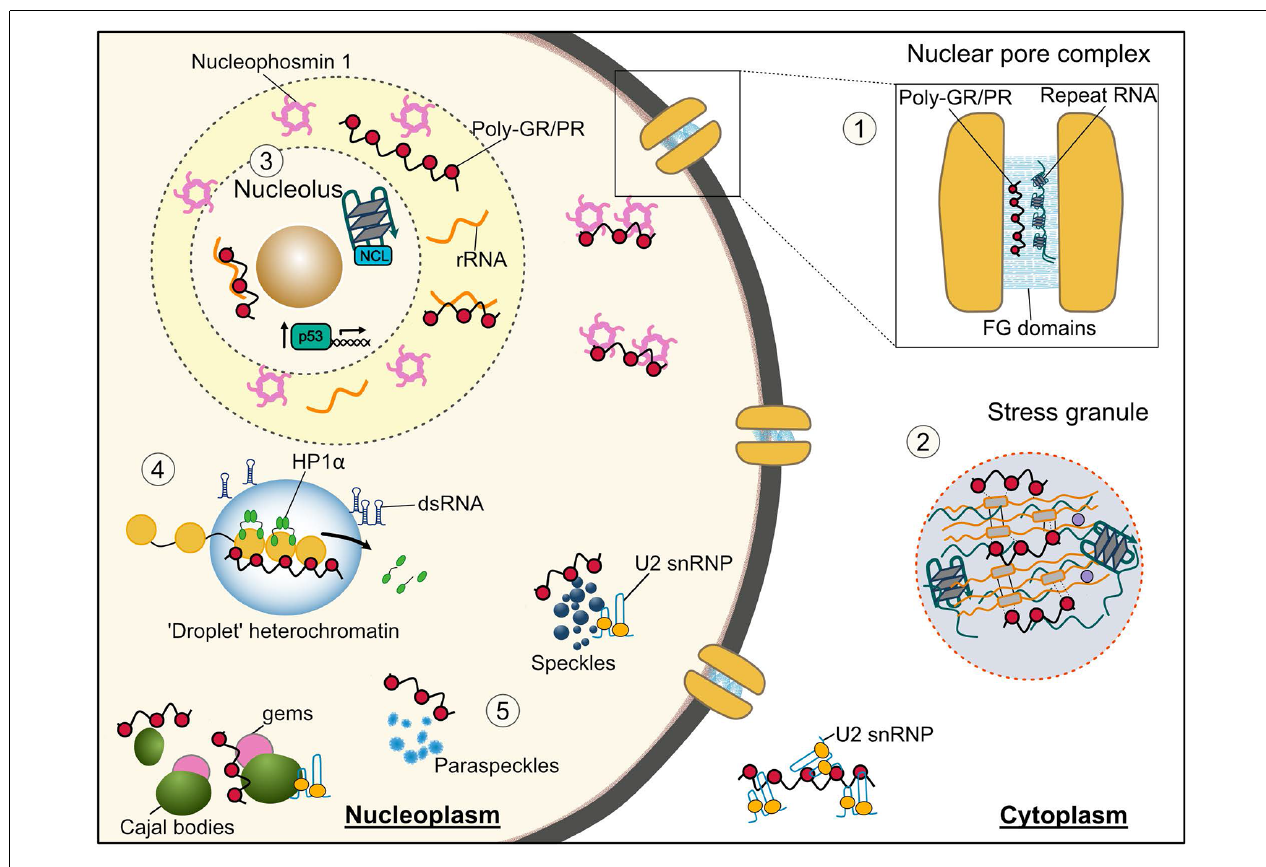
FIGURE 2 | Membraneless organelles and associated functions that are impaired by the C9orf72 arginine rich DPRs and G 4 C 2 repeat RNA. (1) Nuclear pore complex—Phenylalanine-glycine low complexity domains (LCDs) of nuclear pore proteins (nucleoporins) phase separate into a selective hydrogel in the central channel of the nuclear pore. Both the arginine rich DPRs and G 4 C 2 RNA have been shown to interact with these nucleoporins, thus their altered phase separation may underlie the nucleocytoplasmic transport dysfunction seen in C9orf72 -ALS/FTD. (2) Stress granules—both the arginine rich DPRs and repeat RNA bind and cause the aberrant phase separation of LCD containing stress granule proteins inducing formation of poorly dynamic stress granules, which likely contributes to the translational repression seen in C9orf72 -ALS/FTD models. (3) Nucleolus—Poly-PR disrupts the phase separation of the nucleolar protein nucleophosmin with ribosomal RNA leading to its mislocalization from nucleoli to the nucleoplasm, and an impairment in ribosomal biogenesis; this nucleolar stress may also lead to the observed aberrant activation of the p53 pathway. The G-quadruplex forming G 4 C 2 RNA has also been shown to associate with the nucleolar protein nucleolin (NCL) and cause nucleolar dysfunction. (4) Heterochromatin—poly-PR perturbs phase separation of heterochromatin protein 1 α (HP1 α ) displacing it from heterochromatin and resulting in its degradation and an upregulation of repetitive RNA elements which form double-stranded RNA and initiate pathological interferon signaling. (5) Nuclear structures—proteins associated with nuclear speckles, paraspeckles, Cajal bodies and Gems interact with both the arginine rich DPRs and G 4 C 2 RNA. The arginine rich DPRs have specifically been shown alter the liquid-like properties of these organelles and binding to LCD containing U2 snRNP proteins results in their mislocalization from nuclear speckles to the cytosol and reduced splicing